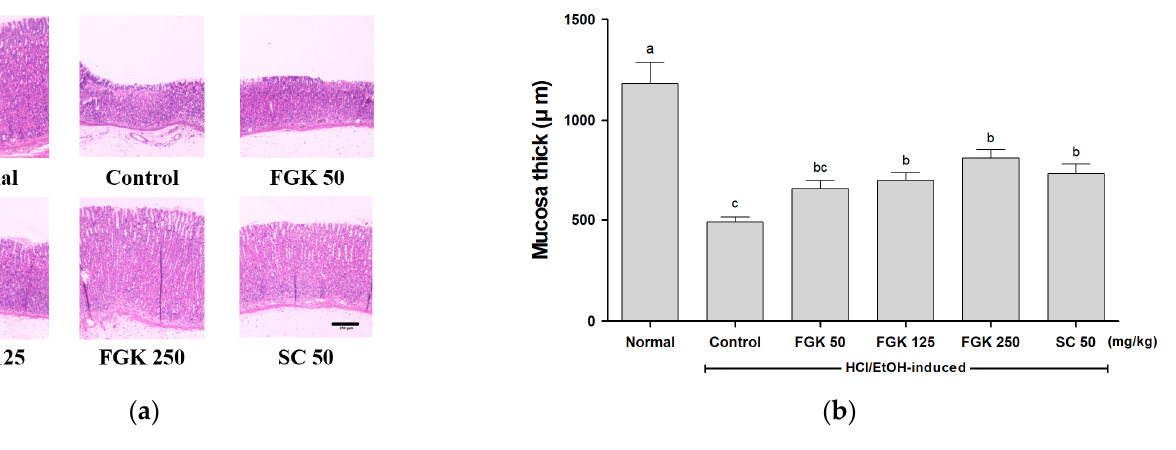
Figure 5. Effects of fermented gold kiwi (FGK) on HCl/EtOH-induced gastric lesion histology. ( a ) Histological sections of gastric mucosa in HCl/EtOH-induced rats; ( b ) effects of FGKP on periulcerative mucosal thickness in HCl/EtOH rats. Normal, rats treated with only DW; Control, rats treated with HCl/EtOH; SC 50, rats treated with HCl/EtOH and sucralfate; FGK, rats treated with HCl/EtOH and FGK (50, 125, and 250 mg/kg). Results are expressed as mean ± SEM (N = 8). a–c Different labels were significantly different at p < 0.05 between treatments, as determined by Tukey’s analysis.